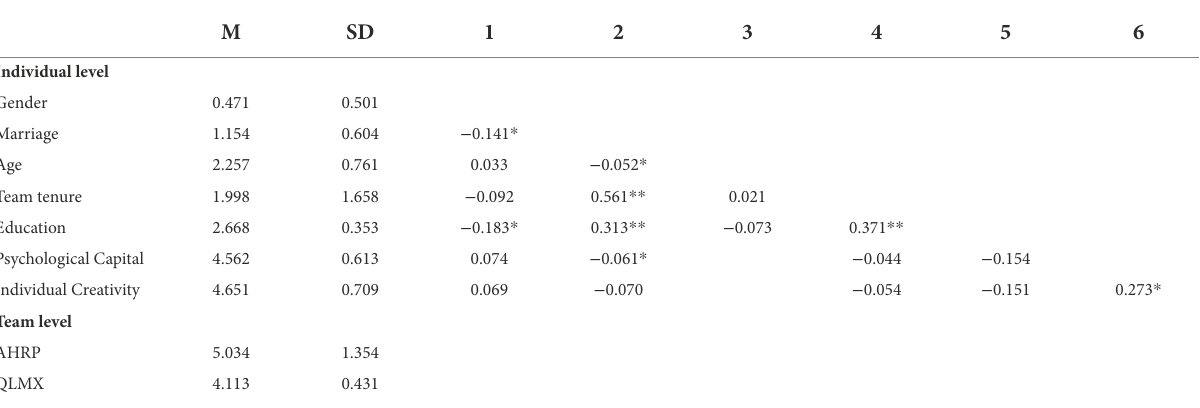
TABLE 2 Descriptive statistics and correlation coefficient of